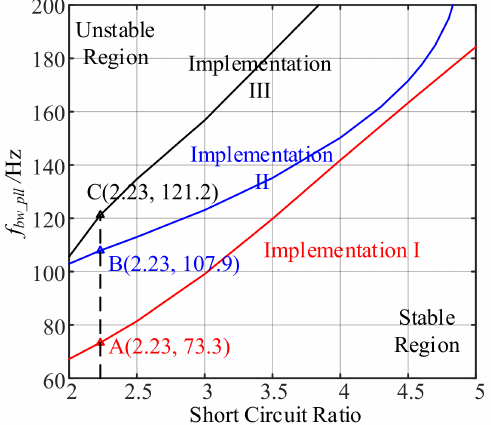
Figure 9. Stability boundaries of the grid-connected converter using different implementations of the adaptive PR controller and SRF-PLL for grid